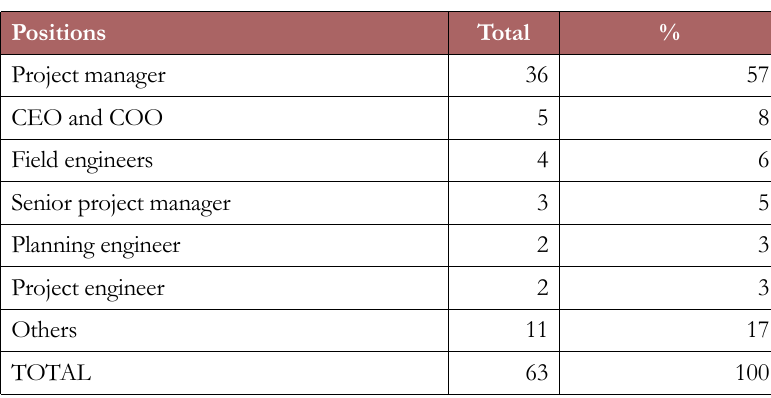
Table 2. Current Designations of Respondents